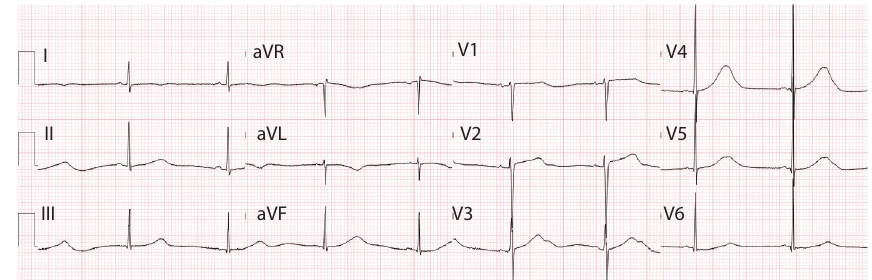
Figure 2: Bradycardia with prolonged